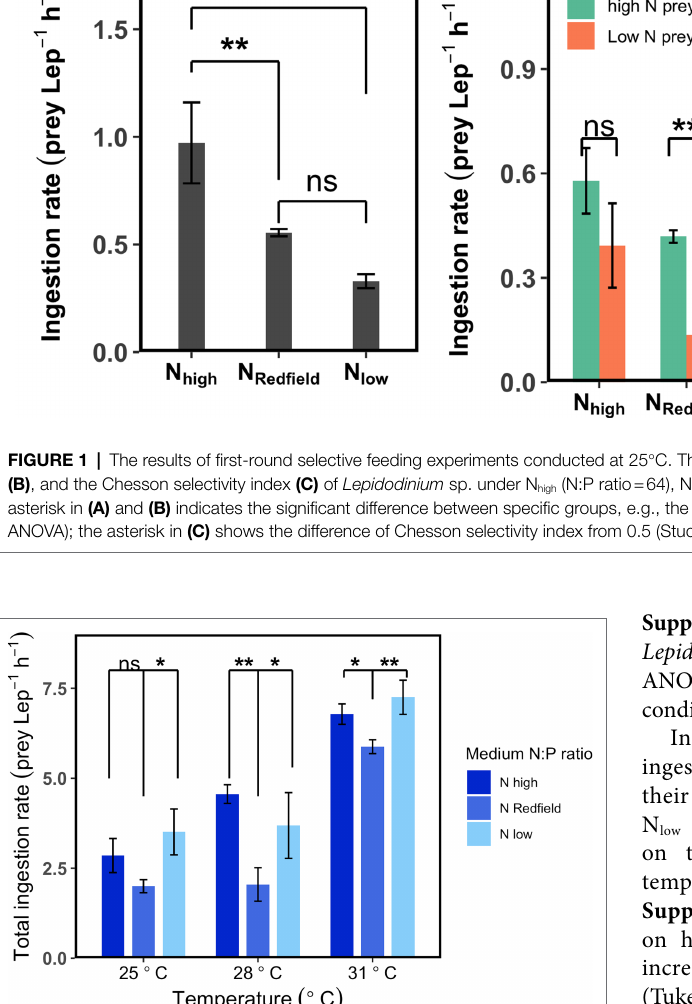
FIGURE 2 | Total ingestion rate of Lepidodinium sp. under three different nutrient treatments (N high , N Redfield and N low ) at three different temperatures (25, 28 and 31 ° C) in the second-round experiments. The asterisk indicates significant difference from N Redfield conditions at each temperature (Tukey HSD Test following a one-way ANOVA; * p < 0.05; ** p < 0.01; *** p < 0.001; and ns: p >